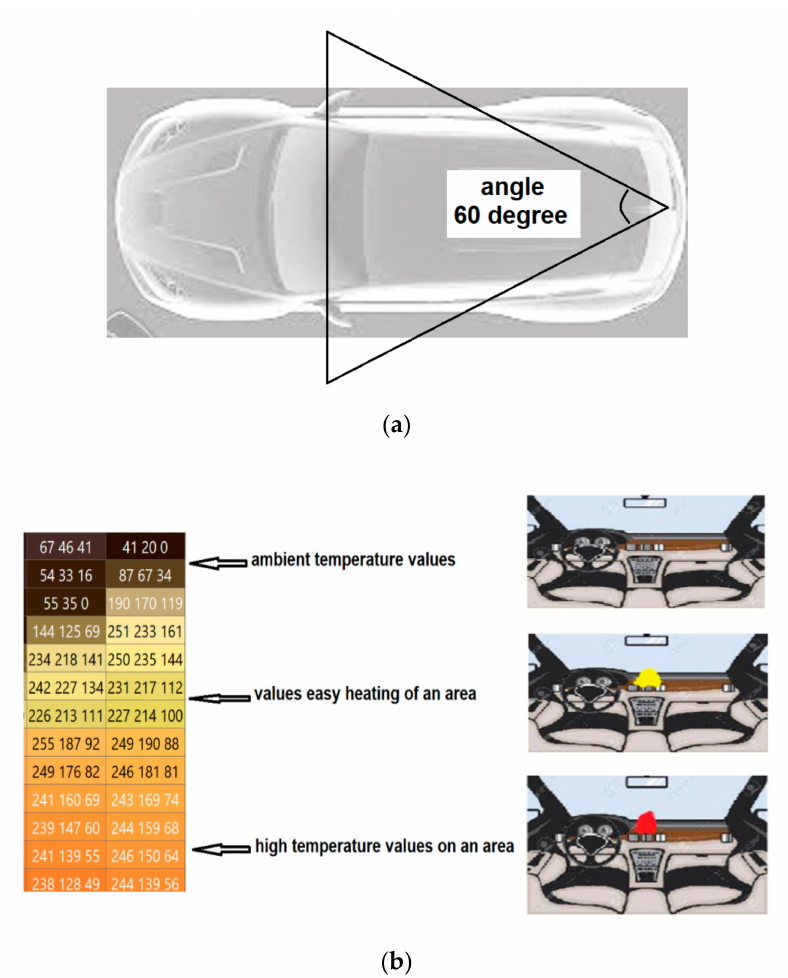
Figure 19. IoT temperature measurement system. ( a ) MEMS sensor location and field of view; ( b ) changing pixel values for ambient temperature (black), values after light heating (yellow), and high flame temperatures